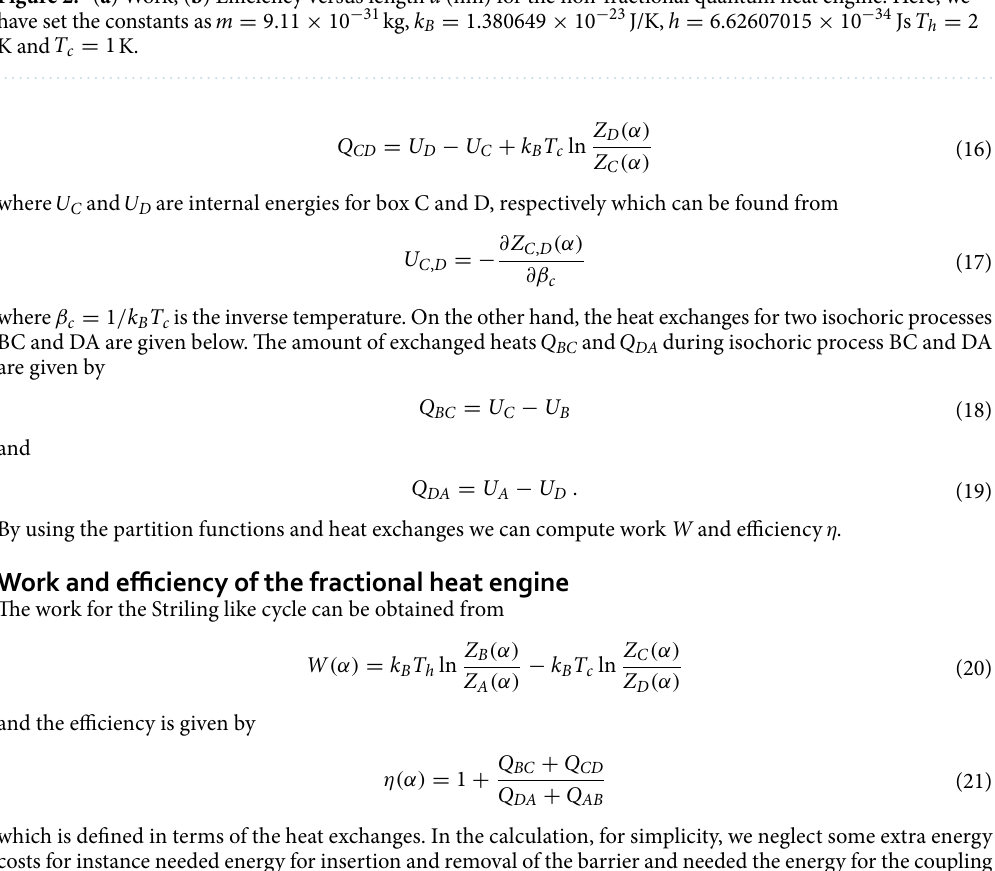
23 6.62607015 10 J/K, h − = ×